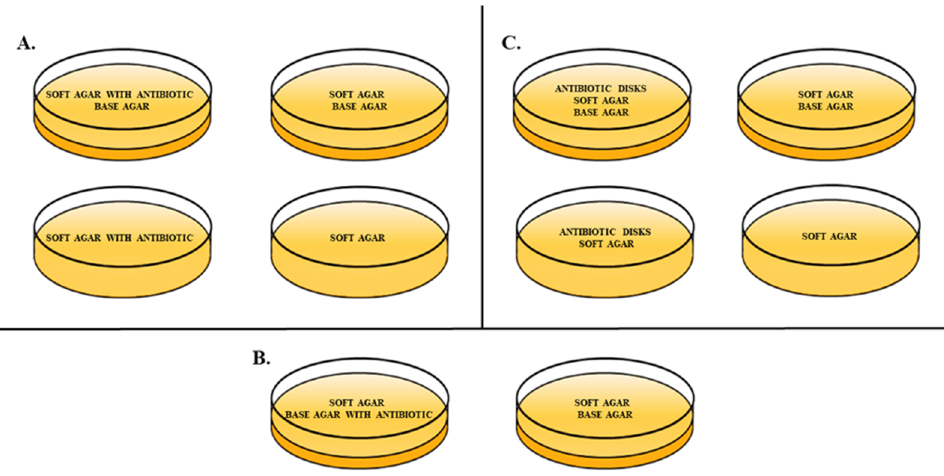
Figure 5. Types of DLA method modifications used in terms of antibiotic addition placement and the presence of a base agar with proper control plates; ( A ) addition of the antibiotic to the soft LB agar with and without base agar with control plates of a standard DLA method and soft agar, ( B ) addition of the antibiotic to the base LB agar with a standard DLA method control plate, ( C ) addition of the antibiotic as antibiotic disks applied onto plates with soft and base LB agar, or with only the soft LB agar with control plates of a standard DLA method and soft agar.